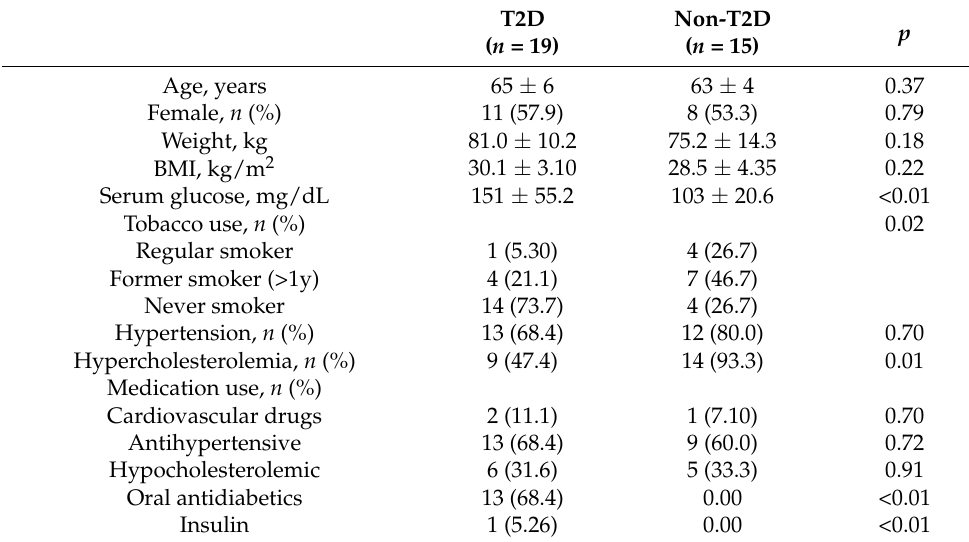
Table 1. Characteristics of study